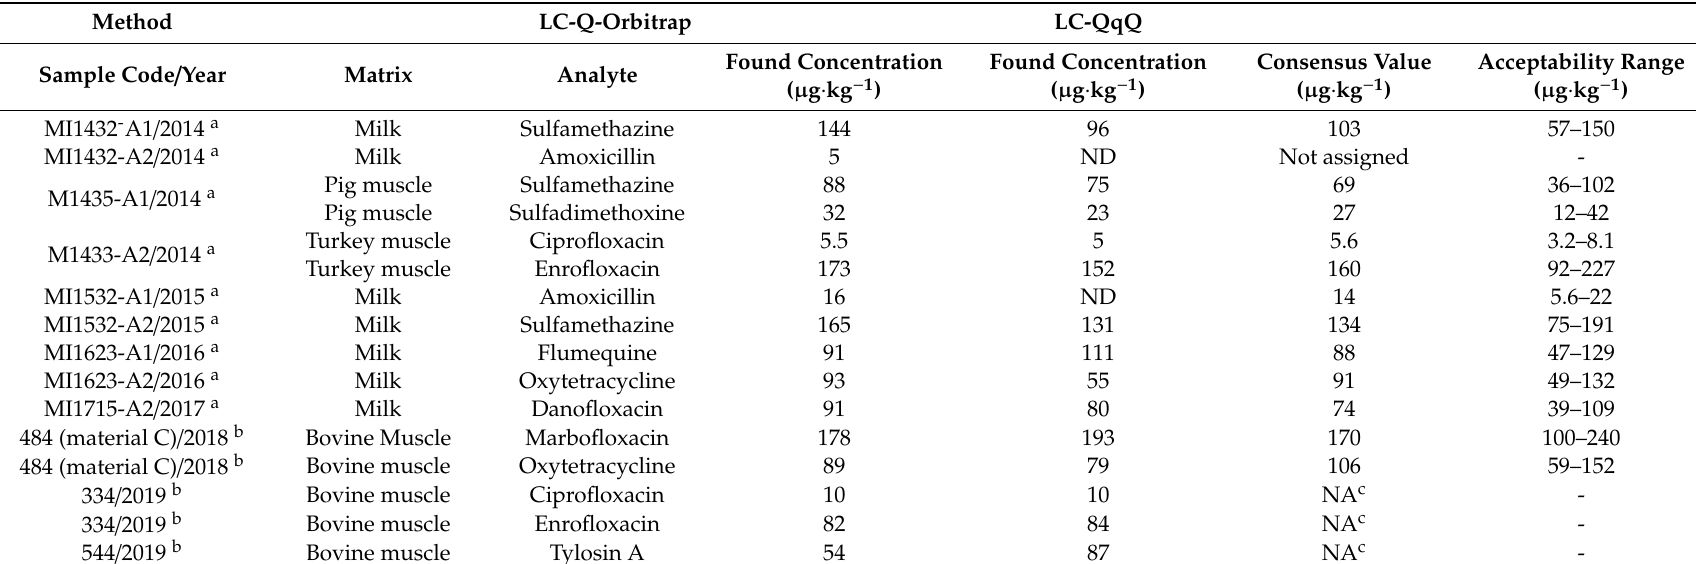
Table 4. Participation in Proficiency Test Schemes: comparison between